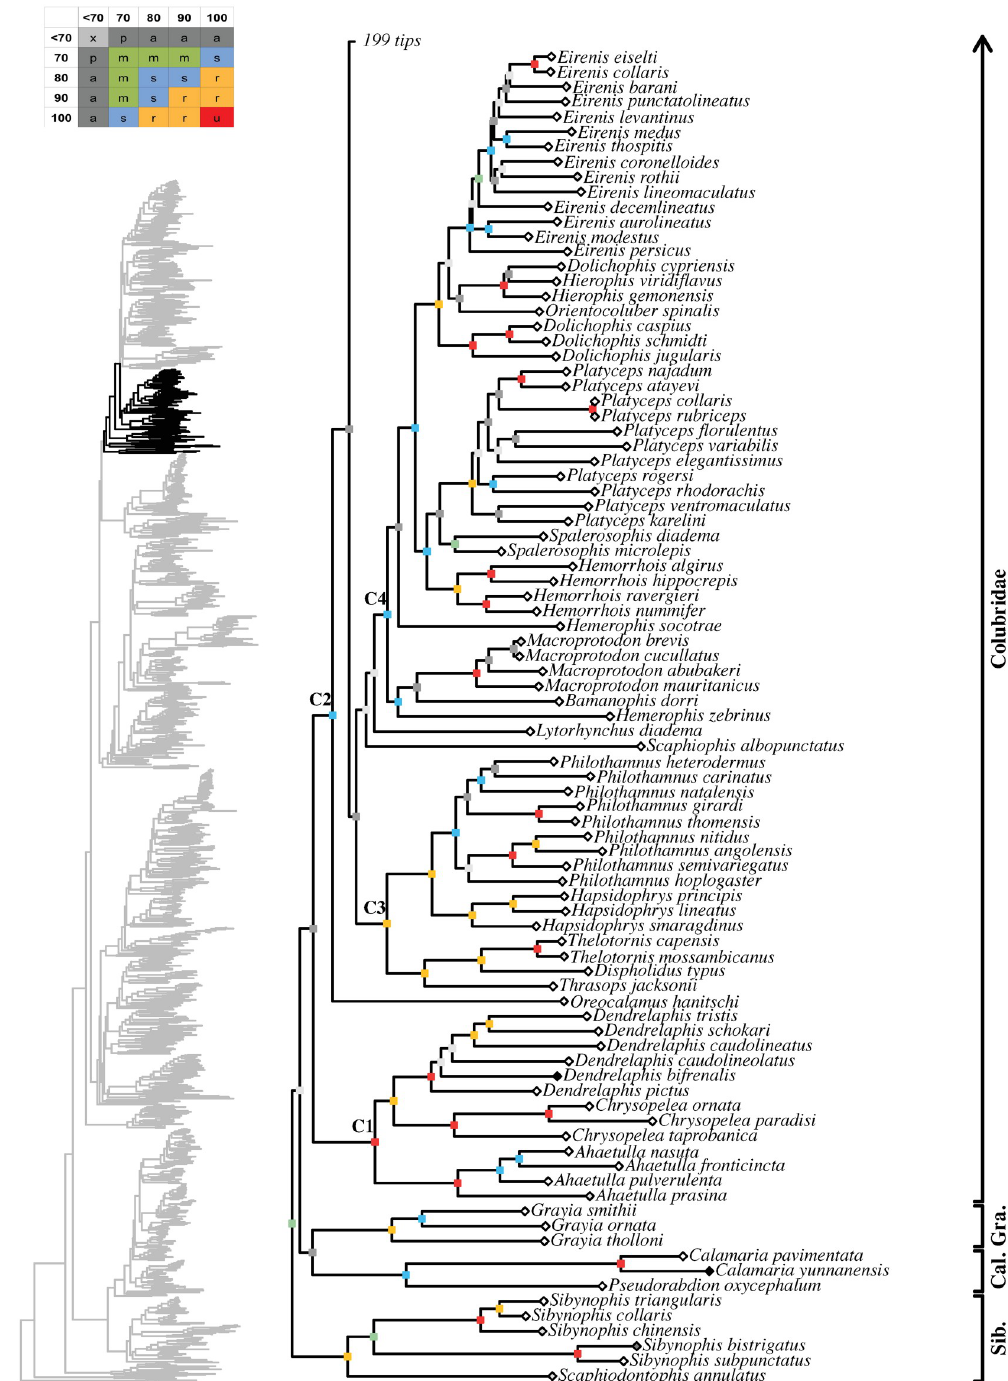
Fig 19. Maximum likelihood species-level phylogeny of Colubroides (continued). Families Sibynophiidae, Calamariidae, Grayiidae, and Colubridae.